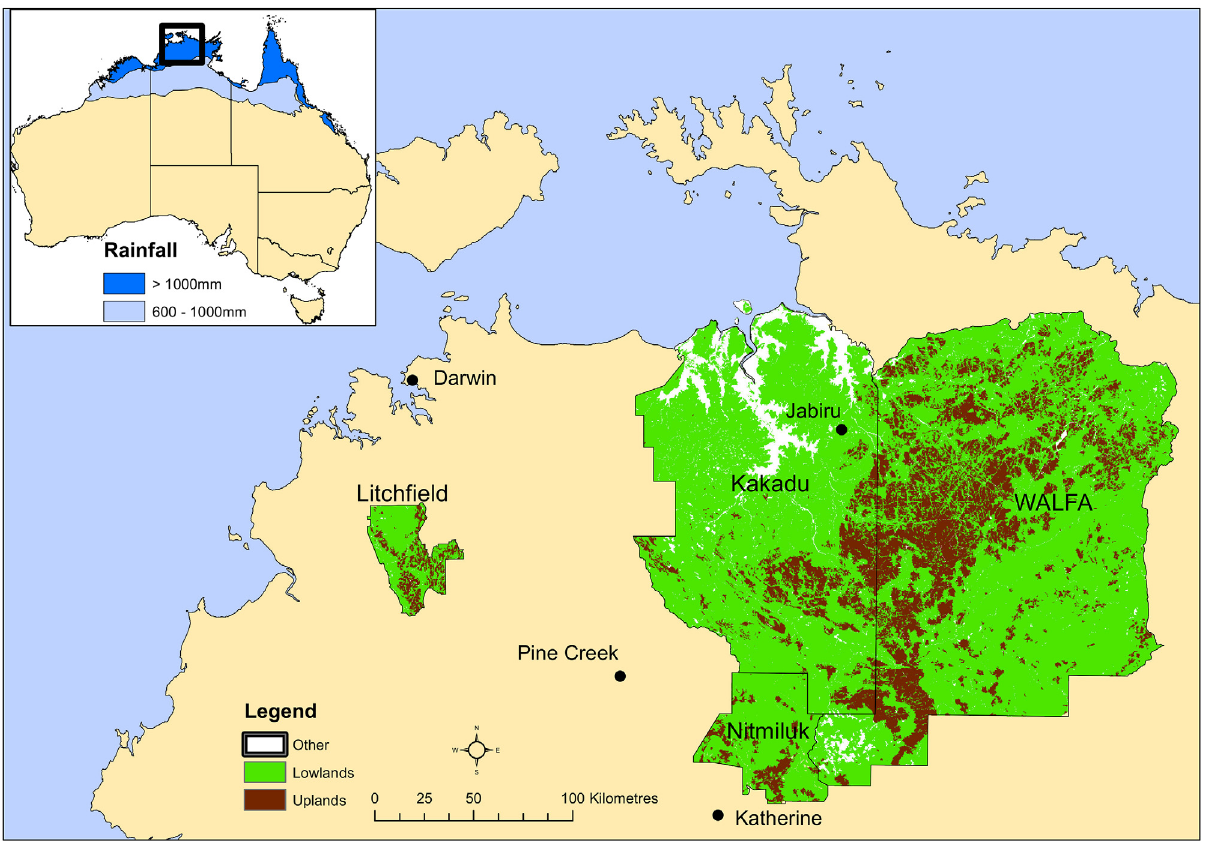
Fig 1. Location of the four study sites in Australia ’ s ‘ Top End ’ . The inset map depicts two regions for which there are current savanna burning accounting methods — annual rainfall > 1,000 mm, and 600 – 1,000 mm y -1 . Refer text for